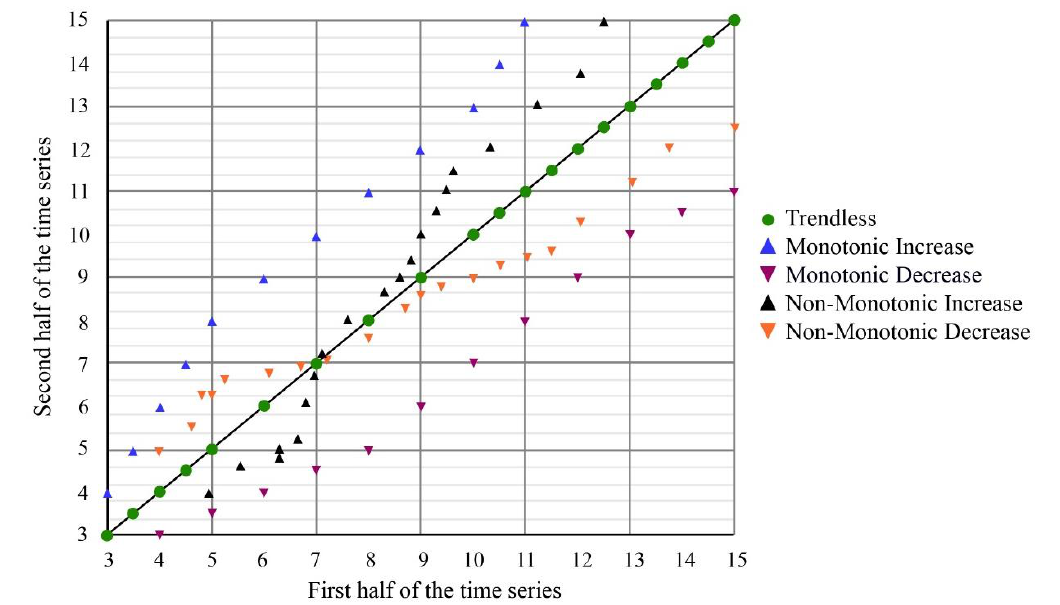
Figure 2. A generalized illustration of innovative trend analysis showing different trends of any given time series.